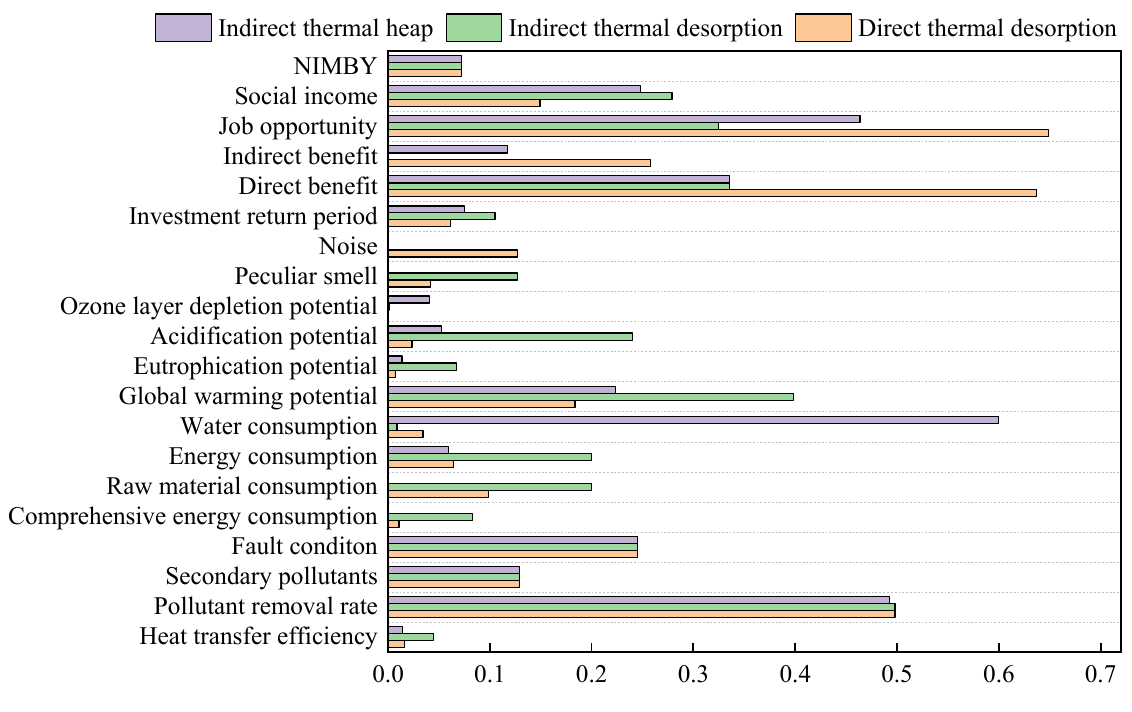
Figure 4. Secondary indicators of the three ex situ thermal desorption processes.